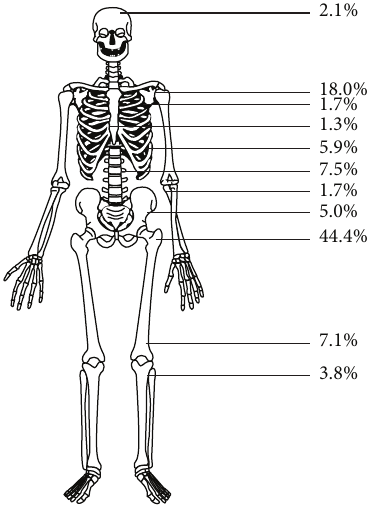
Figure 7: Anatomic distribution of 239 clear cell chondrosarcomas reported in 44